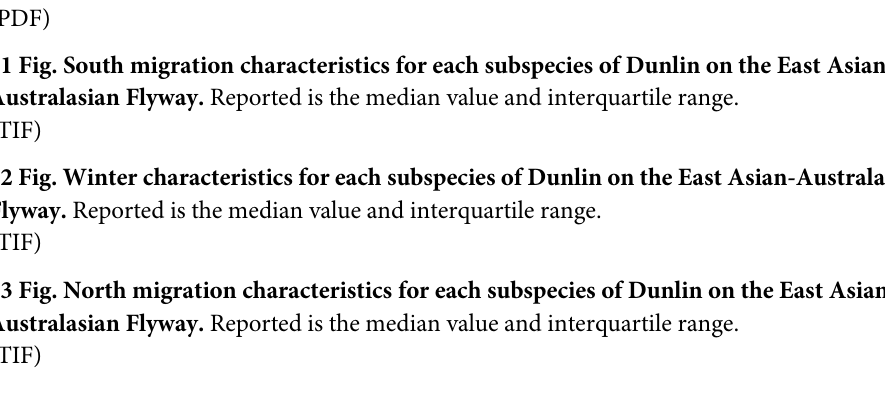
S1 Table. South migration timing of Dunlin subspecies by migration region. (PDF) S1 Fig. South migration characteristics for each subspecies of Dunlin on the East Asian- Australasian Flyway. Reported is the median value and interquartile range. (TIF) S2 Fig. Winter characteristics for each subspecies of Dunlin on the East Asian-Australasian Flyway. Reported is the median value and interquartile range. (TIF) S3 Fig. North migration characteristics for each subspecies of Dunlin on the East Asian- Australasian Flyway. Reported is the median value and interquartile range.